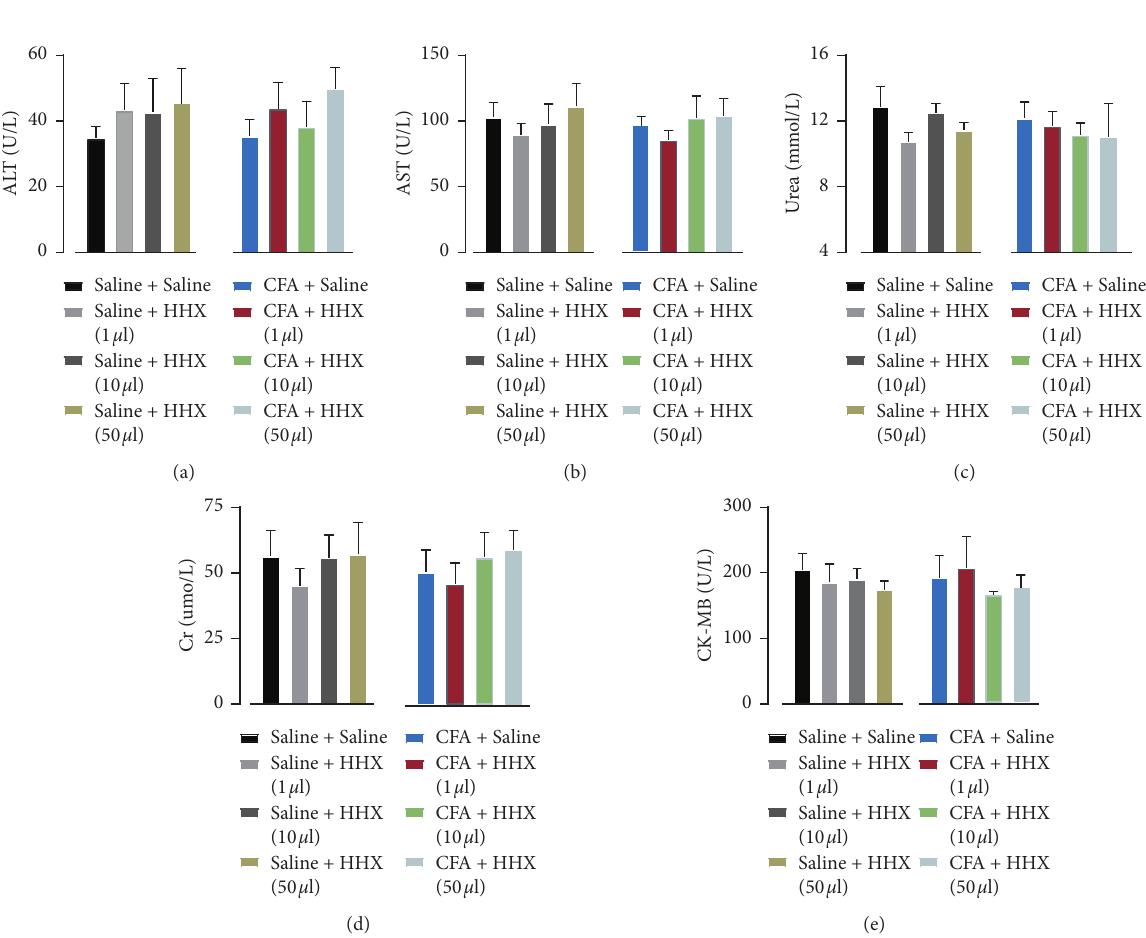
� 0.4097, P � 0 . 8905), and CK-MB (treatment between columns, F (7, 39)